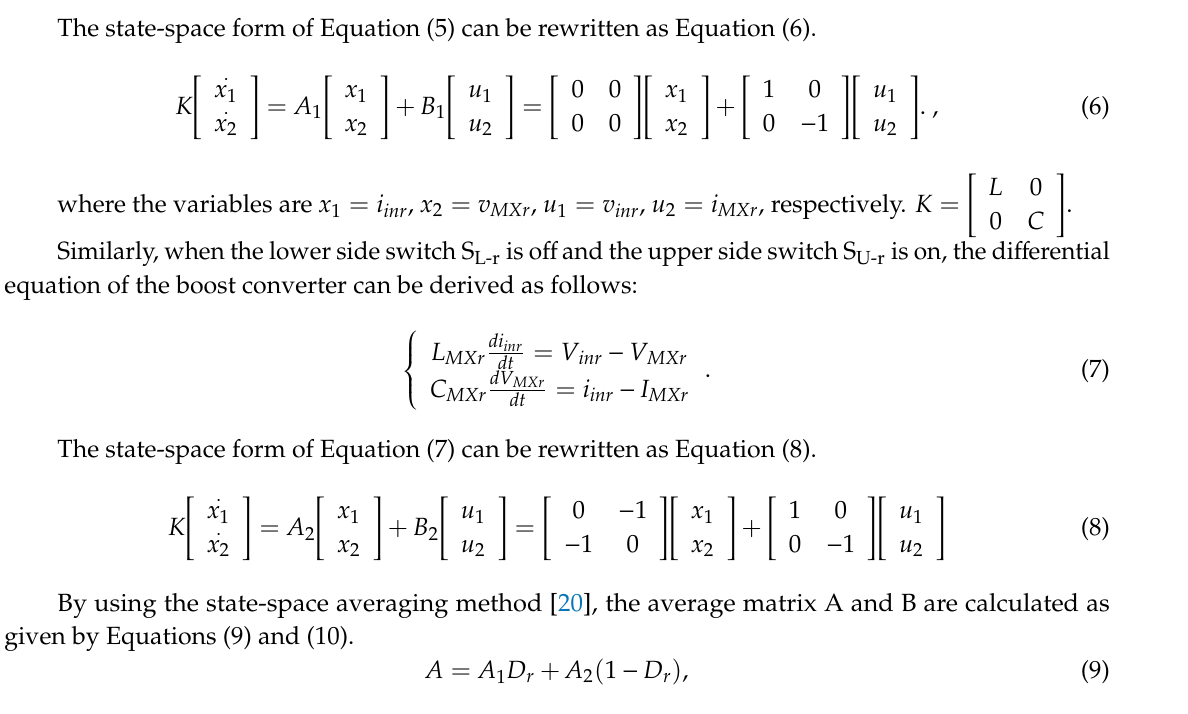
Figure 4. Circuit diagram of DC-DC boost stage in the WEDES system.